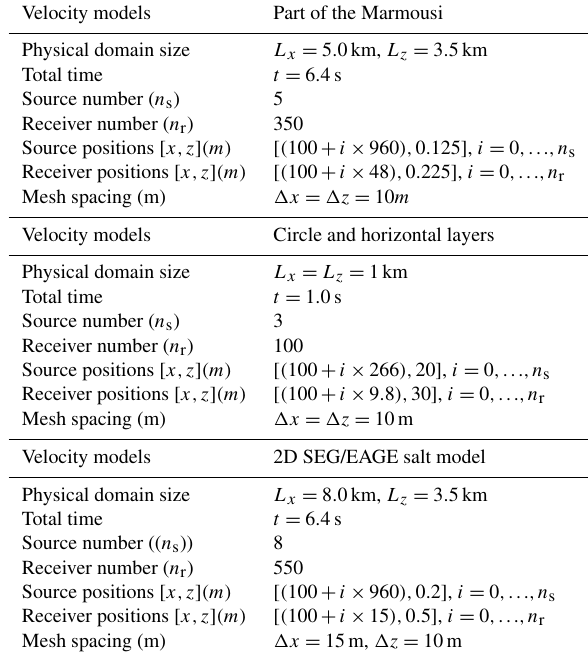
Table 1. Set-up used in the ABC